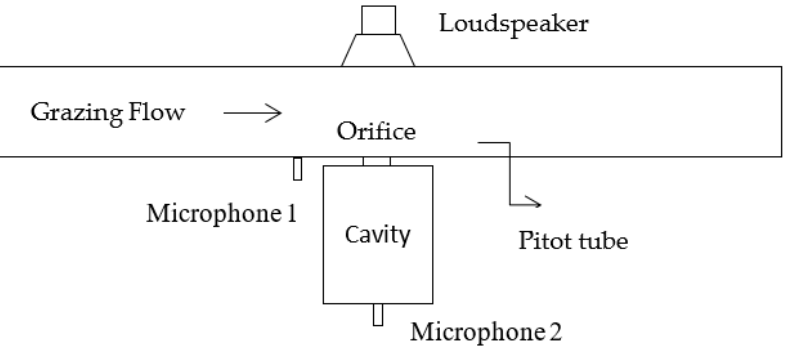
Figure 10. Test rig configuration for the investigation of grazing flow, Jing et al. [23]. Table 2. Geometric specifications of the orifice liners from the experiment by Jing et al. [23]. Liner